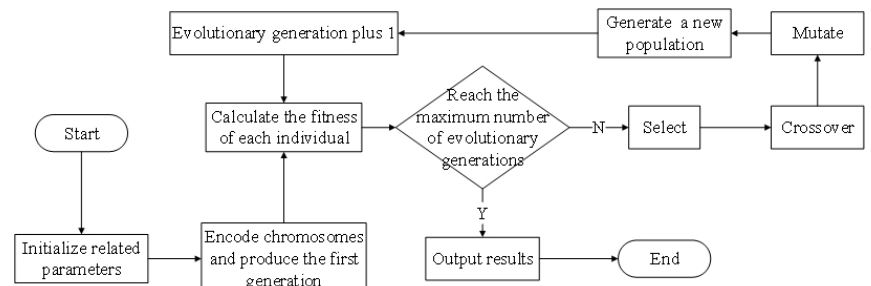
Figure 3. Basic step of the optimization model.